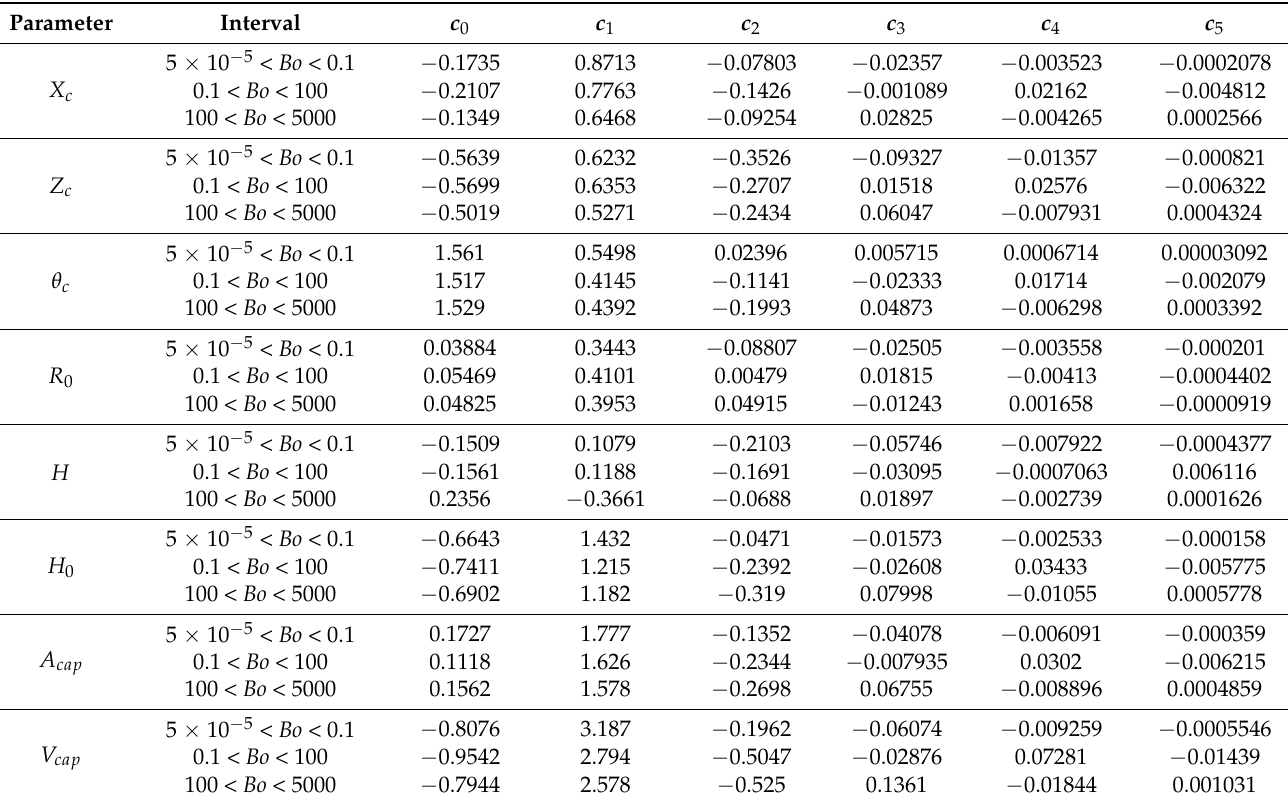
Table 5. Coefficients of the fifth-order polynomial for fitting the bubble parameters.